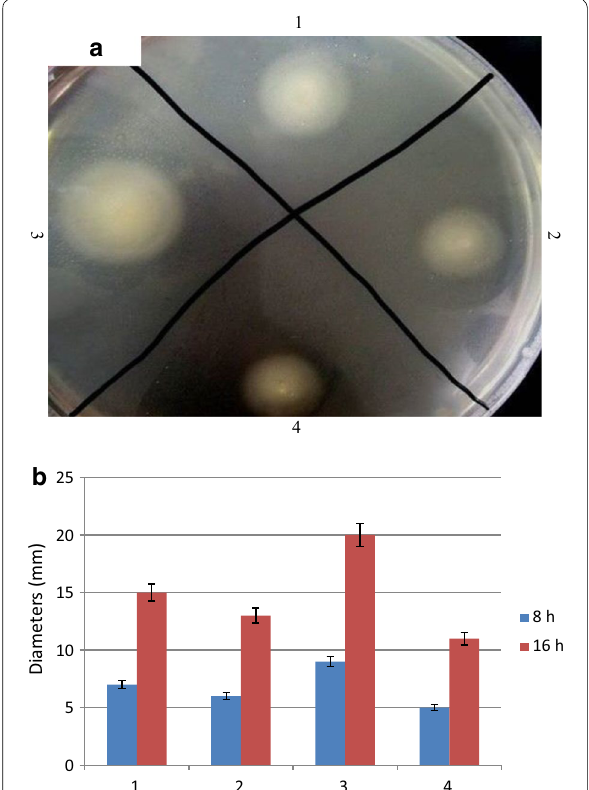
Fig. 1 a Motility experiment of the strains. (1) Motility experiment of E. coli MG1655. (2) Motility experiment of the revertants. (3) Motility experiment of E. coli MG1655- ΔcpxP. (4) Motility experiment of the overexpression transformants. b Diameters of the strains in the LB semi-solid medium for 8 h and 16 h. (1) Diameters of E. coli MG1655. (2) Diameters of the revertants. (3) Diameters of E. coli MG1655- ΔcpxP. (4) Diameters of the overexpression transformants. Values are the mean SD (n ± =